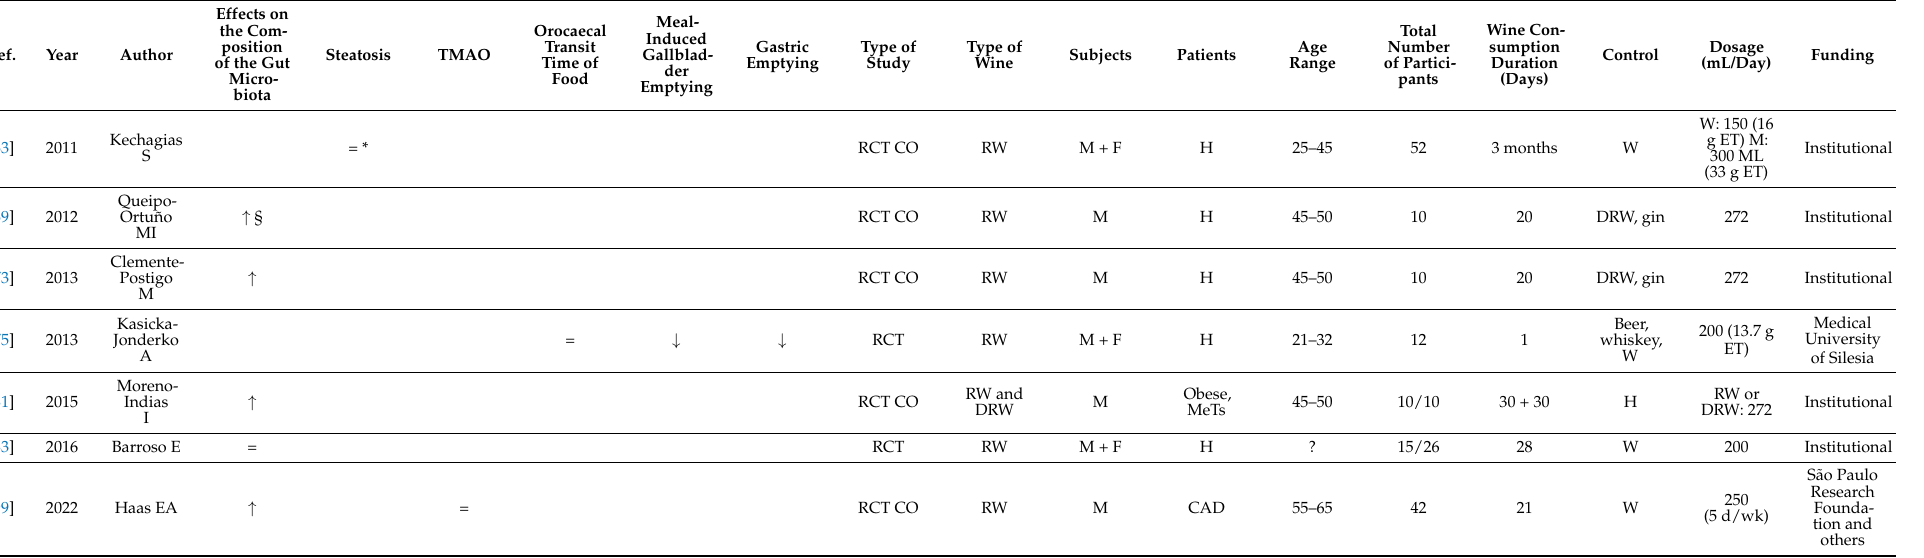
Table 10. Effects of red wine on the gut and its